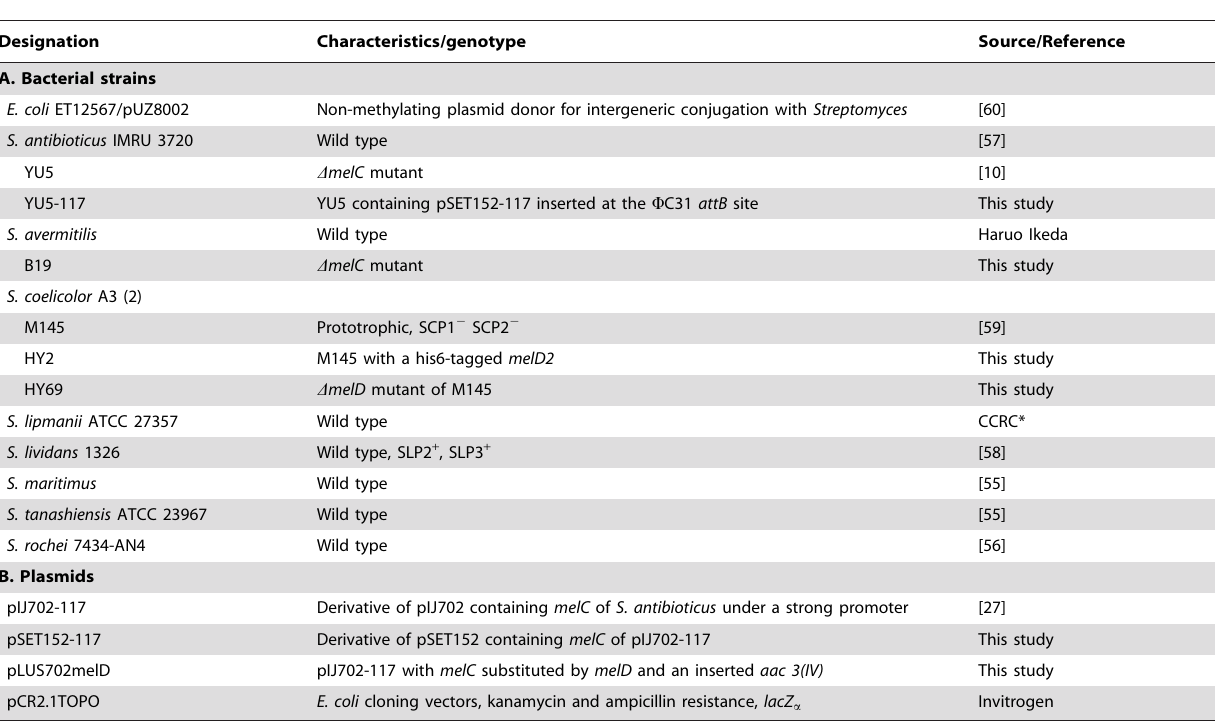
Table 4. Bacterial strains and plasmids used in this